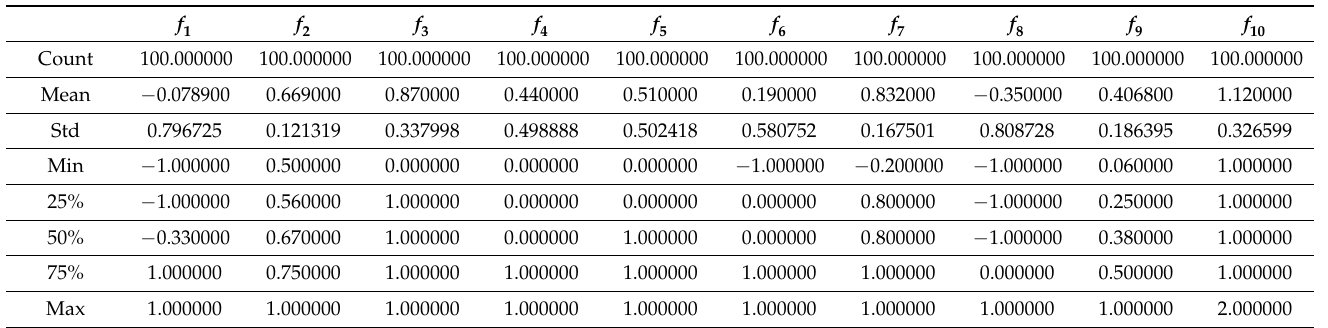
Table 2. Statistical overviews of the fertility dataset.